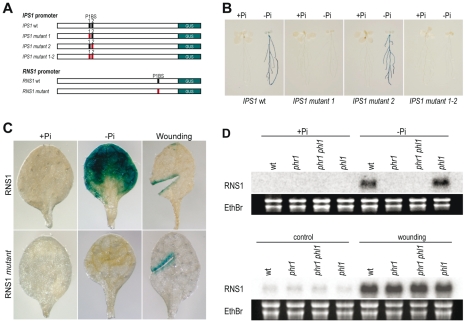
P1BS is a key cis-regulatory motif in Pi starvation responsiveness.(A) Diagram shows IPS1:GUS and RNS1:GUS reporter genes and mutated versions thereof. The P1BS motifs in each gene are highlighted with a vertical bar (wild type, black; mutant, red). (B,C) Histochemical analysis of GUS activity driven by wild type and mutated versions of the IPS1:GUS reporter gene in plants grown in +Pi or −Pi media (B), or driven by wild-type and a mutated version of the RNS1:GUS reporter gene in plants grown in +Pi and +Pi media after wounding (C). (D) Northern analysis of RNS1 gene expression in wild type and phr1, phl1, and phr1 phl1 mutants in response to Pi starvation or wounding. Ethidium bromide-stained rRNA was used as loading control. For the Pi starvation experiment, plants were grown for 7 days in +Pi or −Pi media and RNA prepared from shoots. For the wounding experiment, plants were grown for 14 days, and wounded and unwounded control leaves were harvested for histochemical analysis of GUS activity and for RNA isolation 8 h after wounding.